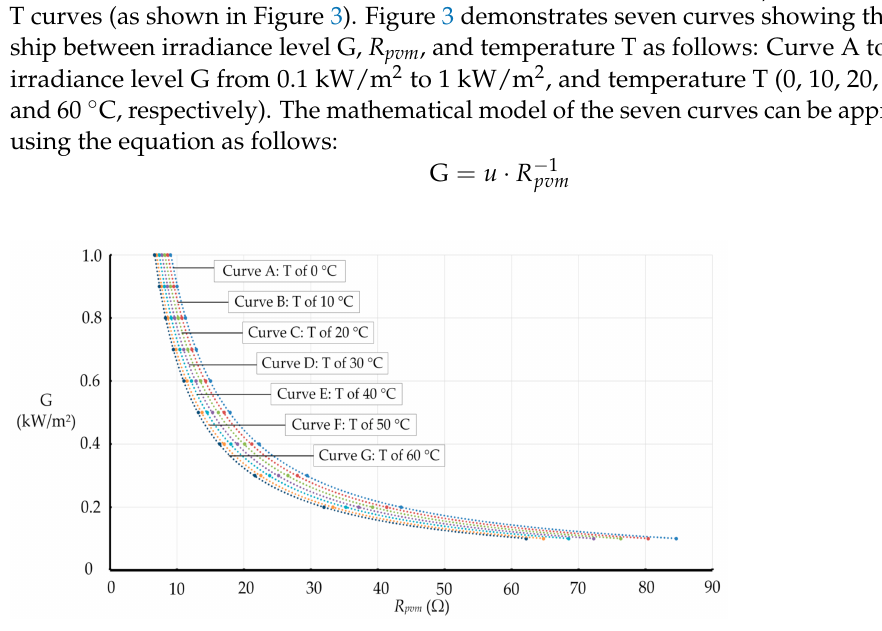
Figure 3. Relationship between G, R pvm , and